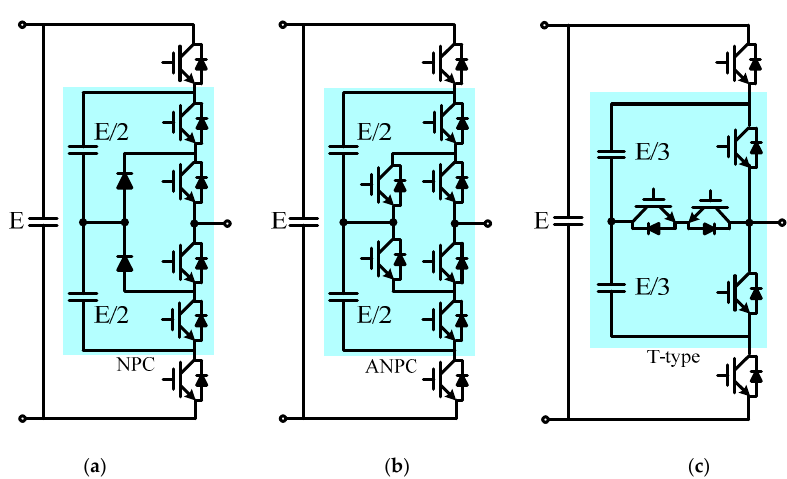
Figure 8. Hybrid clamped nest NPC converters. ( a ) 4L NNPC converter [19], ( b ) 4L nest ANPC converter, ( c ) 4L nest T ‐ type NPC converter [22].